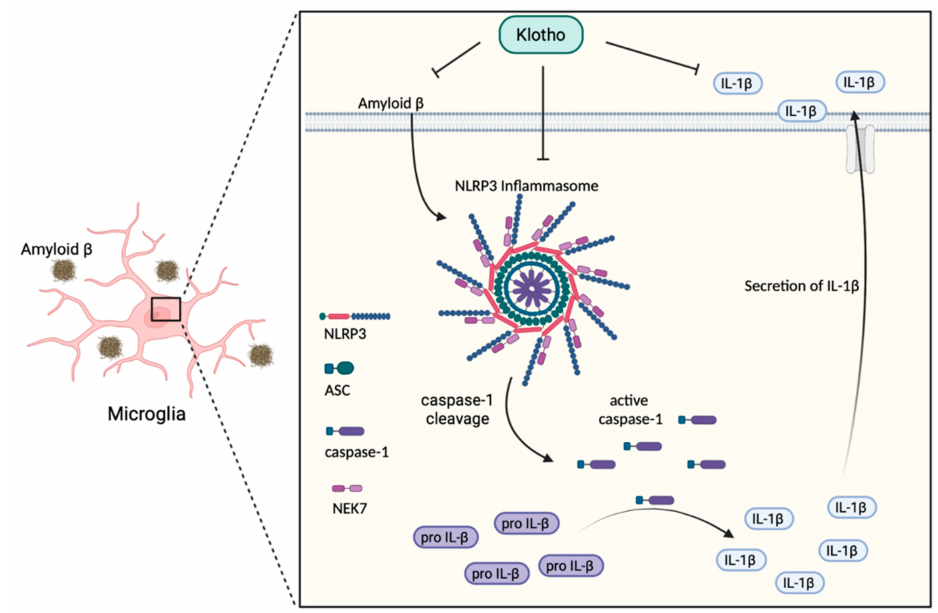
Figure 2. Effects of Klotho on the NLRP3/caspase-1 signaling pathway in AD. Klotho inhibits the accu- mulation of amyloid β peptide which can affect microglia directly and stimulate the NLRP3/caspase- 1 signaling in the brain. The black arrow represents the consequence of A β stimulation. NLRP3: Nucleotide-binding oligomerization domain leucine-rich repeat and pyrin domain-containing protein 3; ASC: Apoptosis-associated speck-like protein containing a caspase recruitment domain; pro IL-1 β : inactive interleukin-1 β precursor; IL-1 β : interleukin-1 β